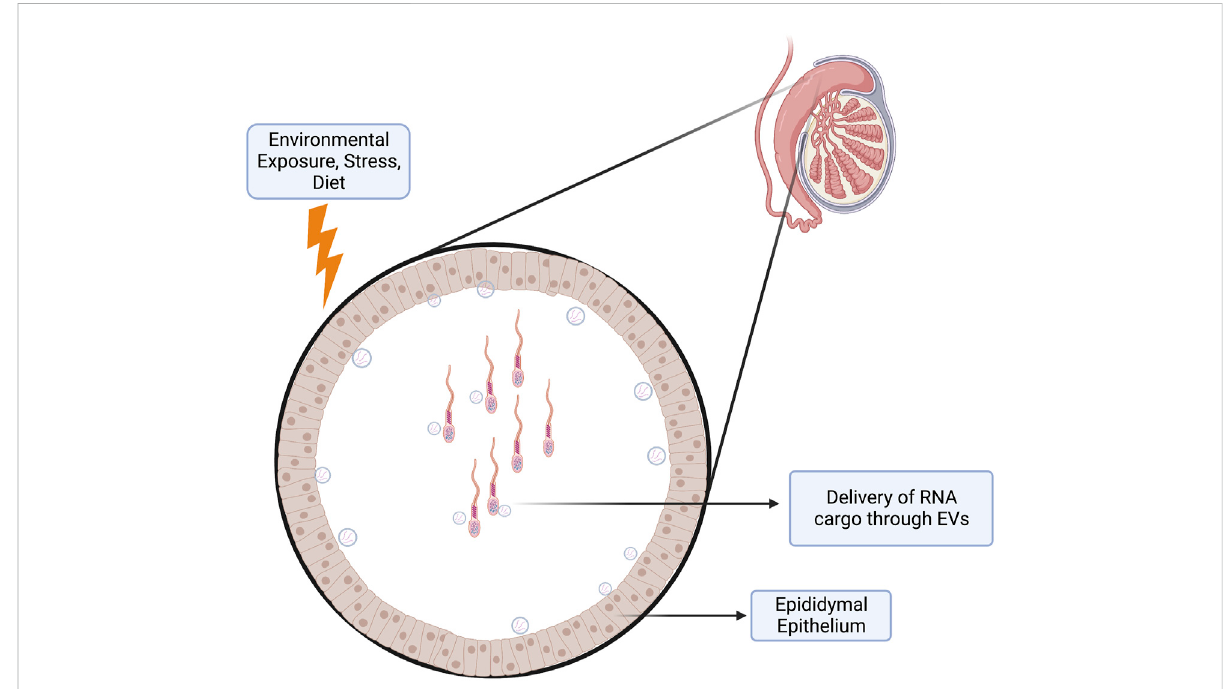
FIGURE 3 Epididymis as an Environmental Sensor. The epididymal (mainly the caput and corpus) epithelium functions as a sensor of paternal environmentalstressors.Thisepitheliummayrespondtothesestressorsbyalteringitstranscriptionalprogramtodeliverpayloadsofmolecularcargo through extracellular vesicles (epididymisomes) to the passing spermatozoa. These epididymisomes contain avariety of small RNAs that may deliver a layer of epigenetic information to the maturing spermatozoa, which can alter gene programming events in the early